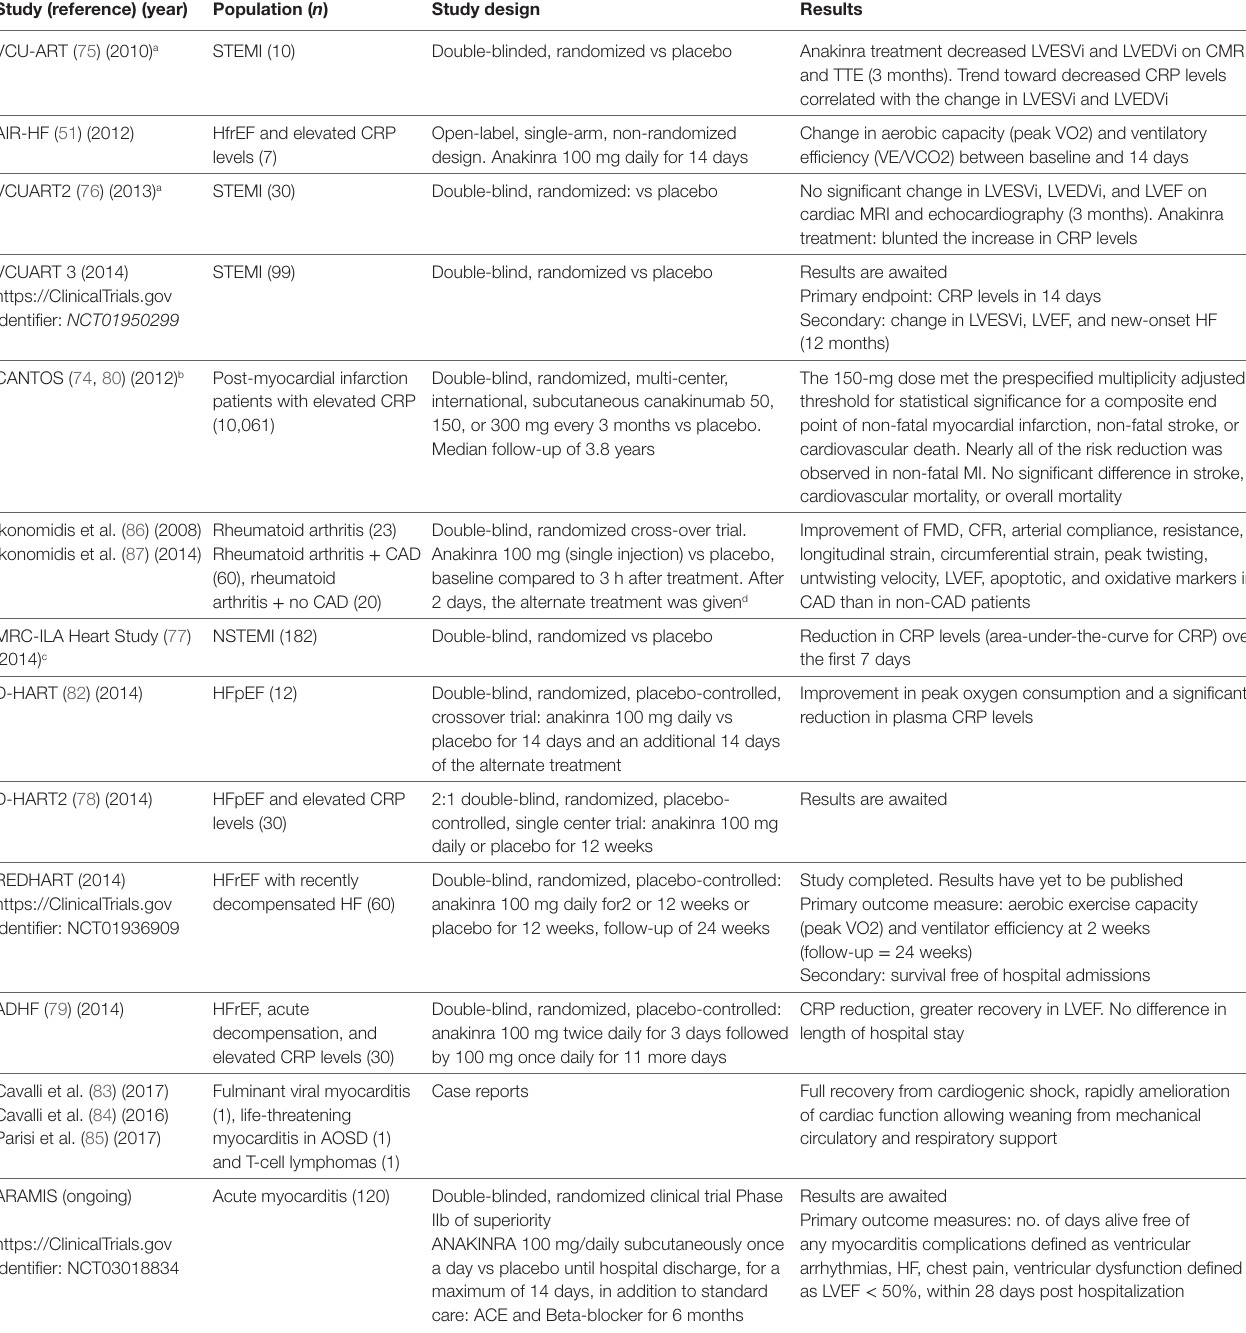
TABLE 1 | Clinical experience with interleukin-1 inhibition in cardiac diseases. Study (reference) (year) population ( n ) Study design Results Double-blinded, randomized vs